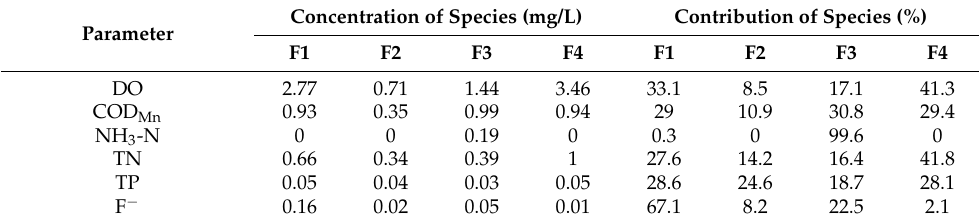
Table 8. Pollution source profile and contribution rate in the midstream.